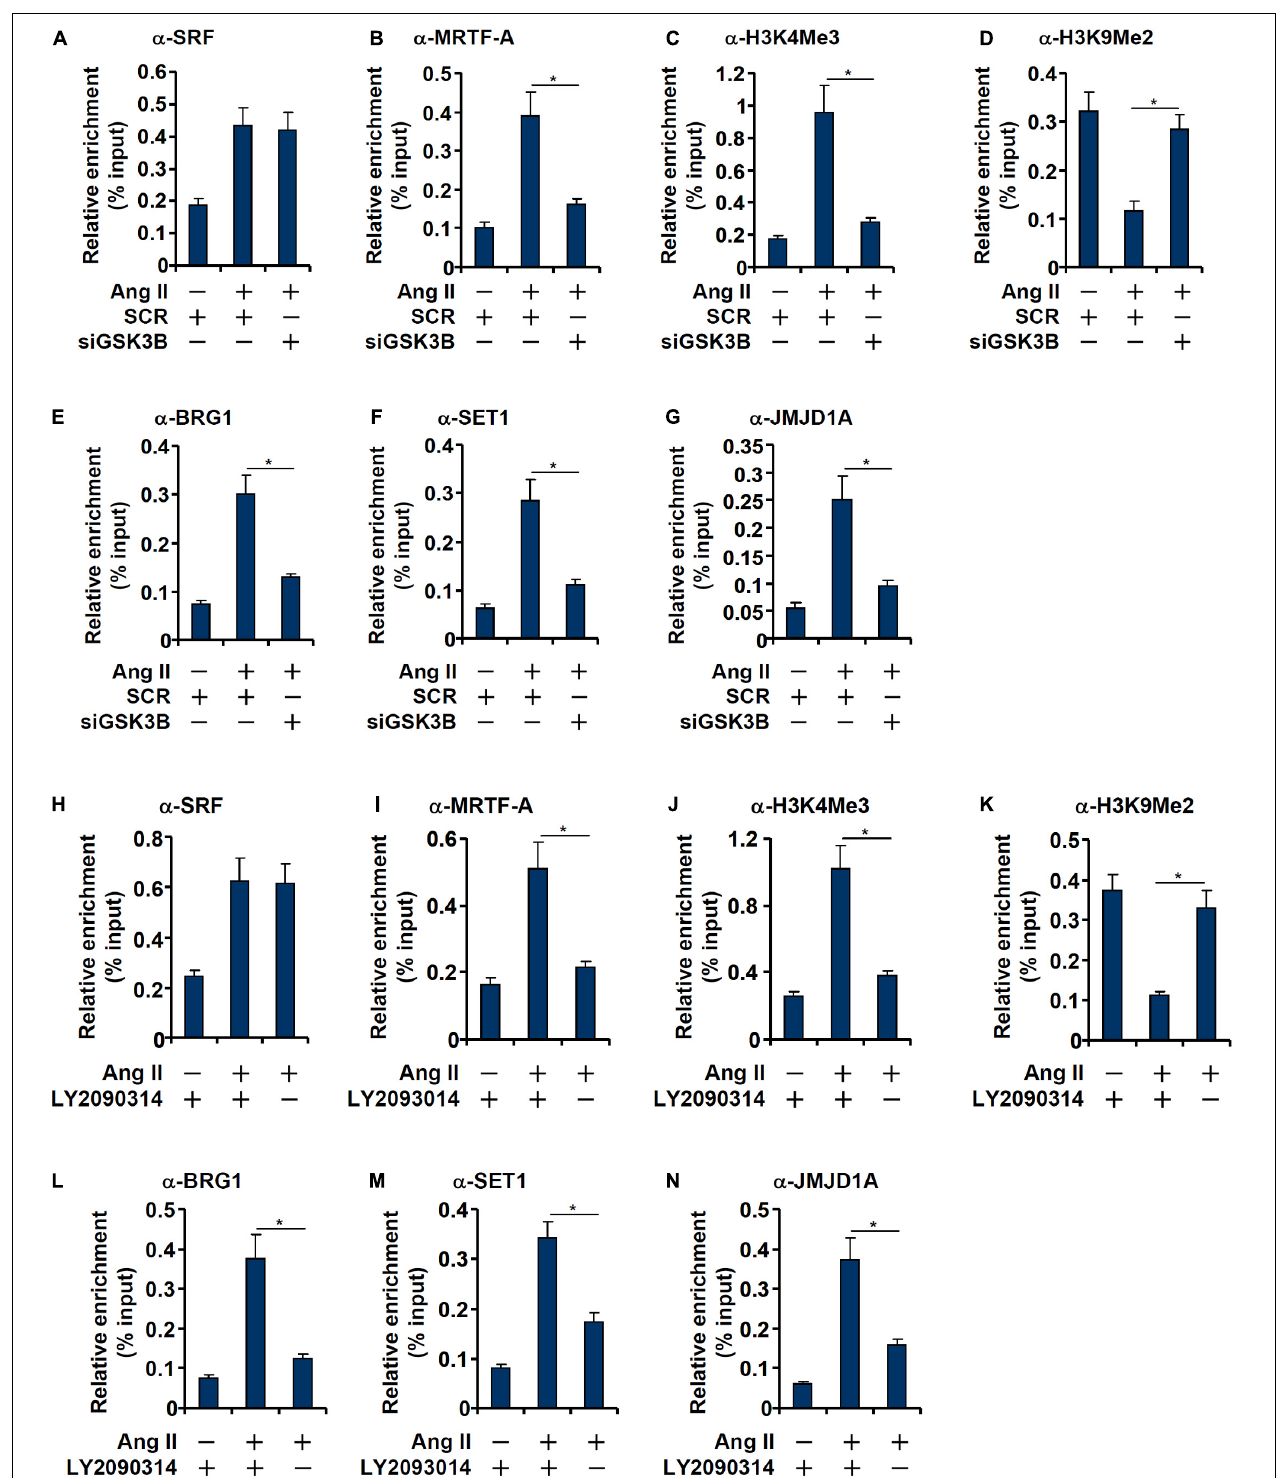
FIGURE 5 | GSK3 knockdown or inhibition attenuates recruitment of co-factors to the ET1 promoter. (A–G) EAhy926 cells were transfected with siRNAs targeting GSK3 β or scrambled siRNA (SCR) followed by treatment with Ang II (0.1 µ M) for 48 h. ChIP assays were performed with anti-SRF, anti-MRTF-A, anti-H3K4Me3, anti-H3K9Me2, anti-BRG1, anti-SET1, and anti-JMJD1A. (H–N) EAhy926 cells were treated with Ang II (0.1 µ M) with or without LY2090314. ChIP assays were performed with anti-SRF, anti-MRTF-A, anti-H3K4Me3, anti-H3K9Me2, anti-BRG1, anti-SET1, and anti-JMJD1A. Error bars represent SD (* p < 0.05, two-way Student’s t -test). All experiments were repeated three times and one representative experiment is shown.